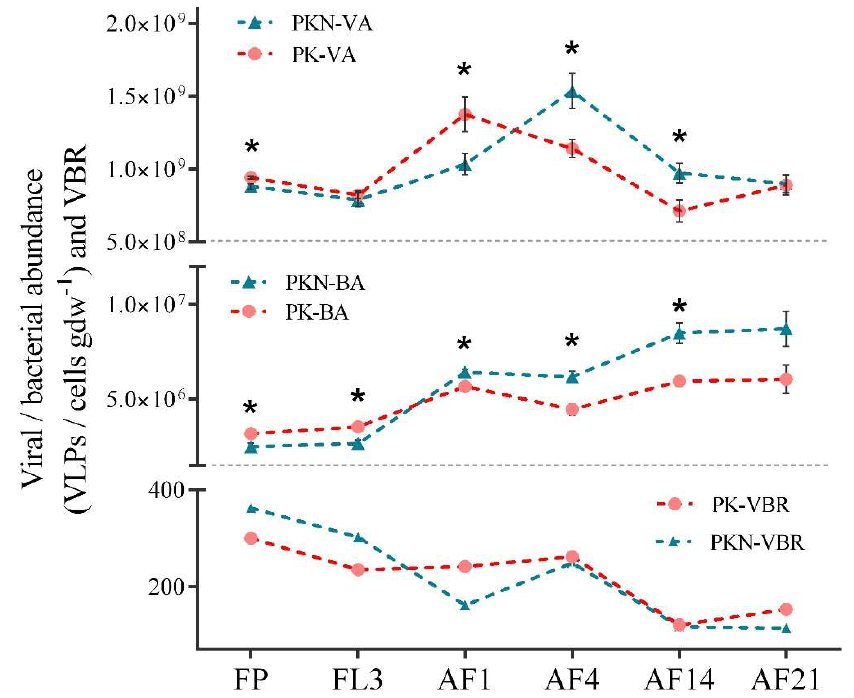
Figure 2. Dynamics in viral abundance (VA), bacterial abundance (BA) and virus-to-bacterium ratio (VBR) in the phosphate and potassium fertilizer (PK) and phosphate, potassium, and nitrogen fertilizer (PKN) groups. The asterisks indicate significant differences are obtained from matched samples ( T -test; *, p < 0.05). FP, representing spring fallow period measurements; FL3, third day of flooding; AF1, 4, 14, 21 refer to the first, fourth, 14th, and 21st days after fertilization, respectively.